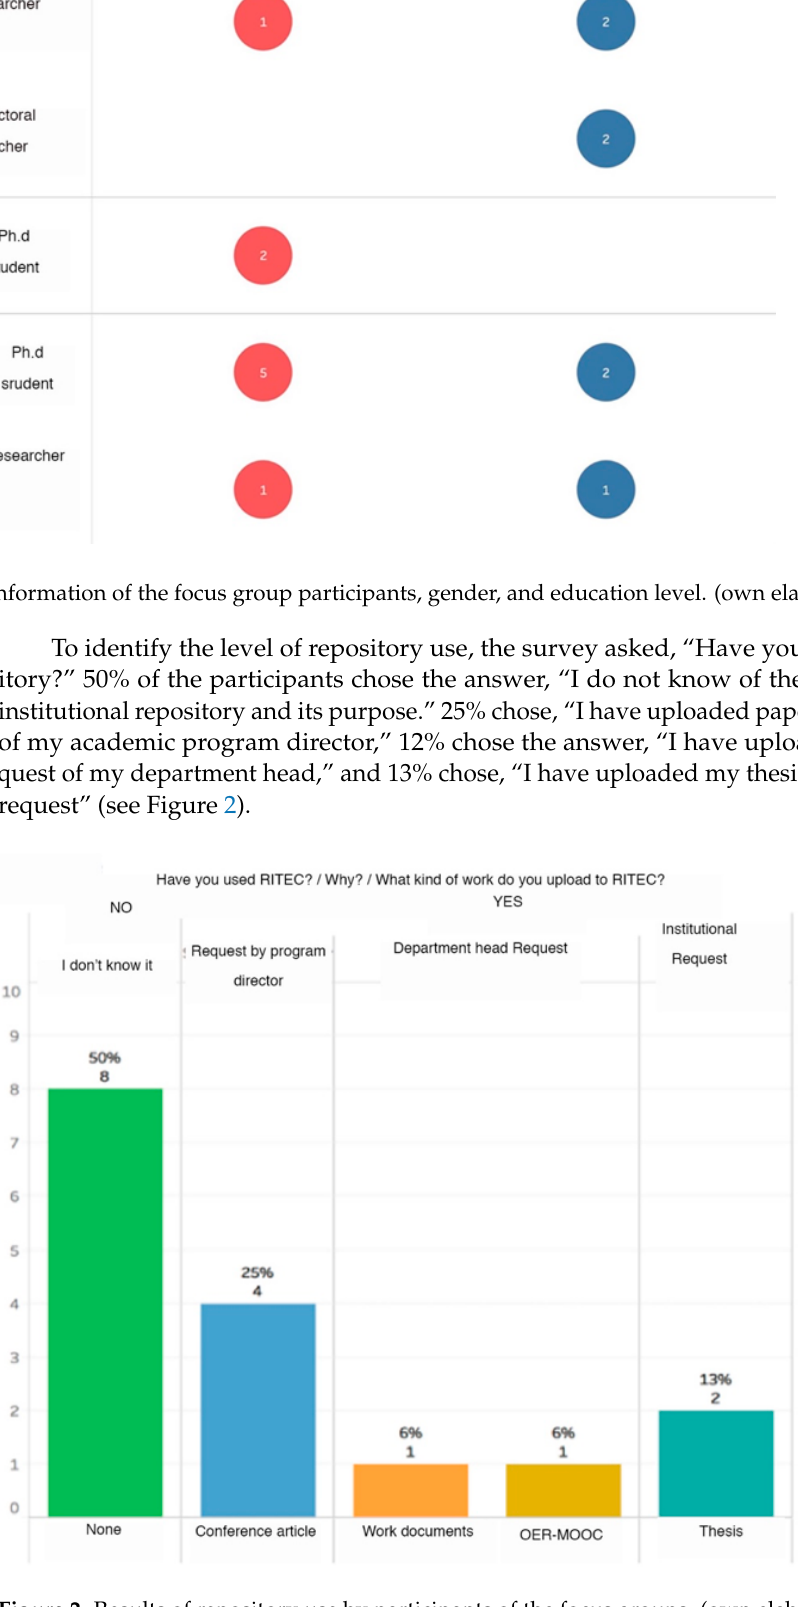
Figure 2. Results of repository use by participants of the focus groups. (own